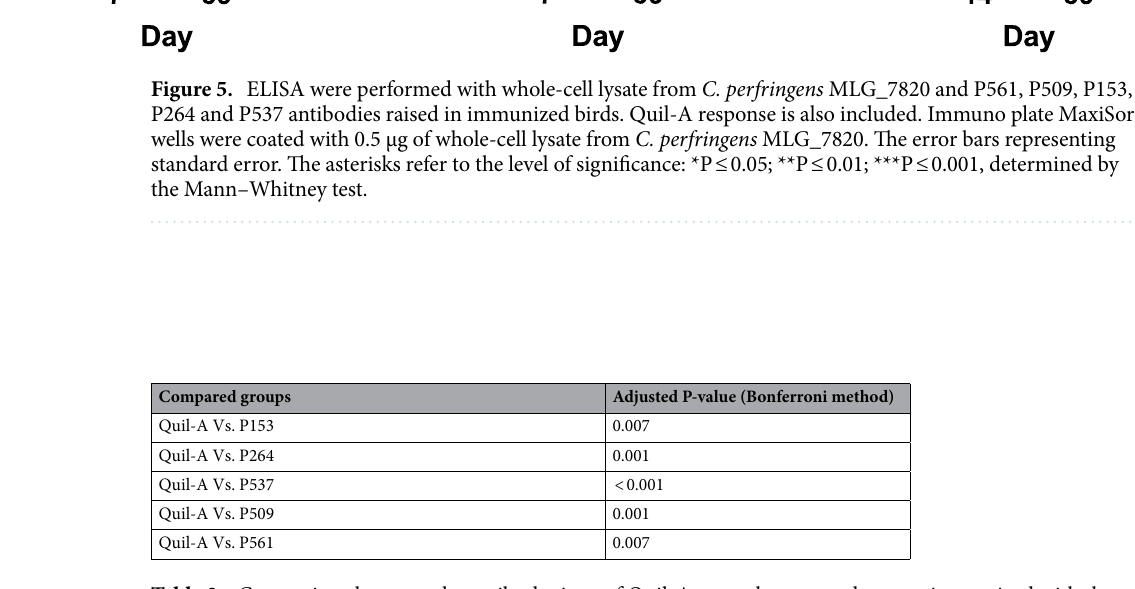
Table 2. Comparison between the antibody titers of Quil-A control group and groups immunized with the candidate proteins, on day 35, against the whole cell lysate of C. perfringens MLG_7820, and their respective